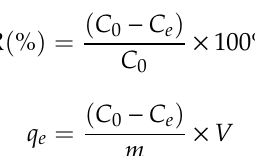
Figure 2. Schematic diagram for the formation of Ca-MOF on the surface of ABS/TPU 3D skeleton.